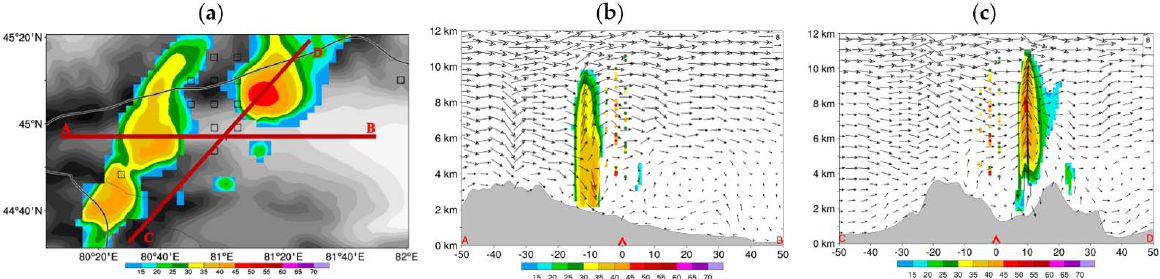
Figure 7. Horizontal and vertical cross-sections of assimilated composite reflectivity fields (unit dBZ) from ( a ) C2Rad for 1-h forecasts beginning at 0700 UTC 30 July 2019. The wind vector (unit m/s, black arrows) is calculated by u and w wind in which w speed is multiplied by 10.0 in ( b , c ) which is the same below. The red triangle in each plot of vertical cross-sections indicates the location of Wenquan station. The red lines indicate vertical cross-sections through AB and CD. The color points indicate the vertical distribution of observed reflectivity fields (unit dBZ).